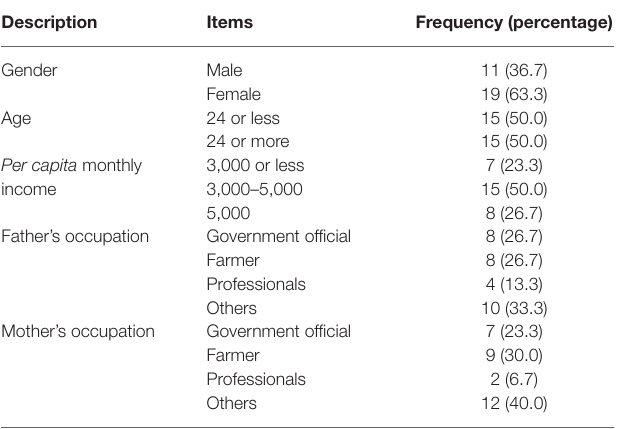
TABLE 1 | Demographic characteristics of the participants ( N =